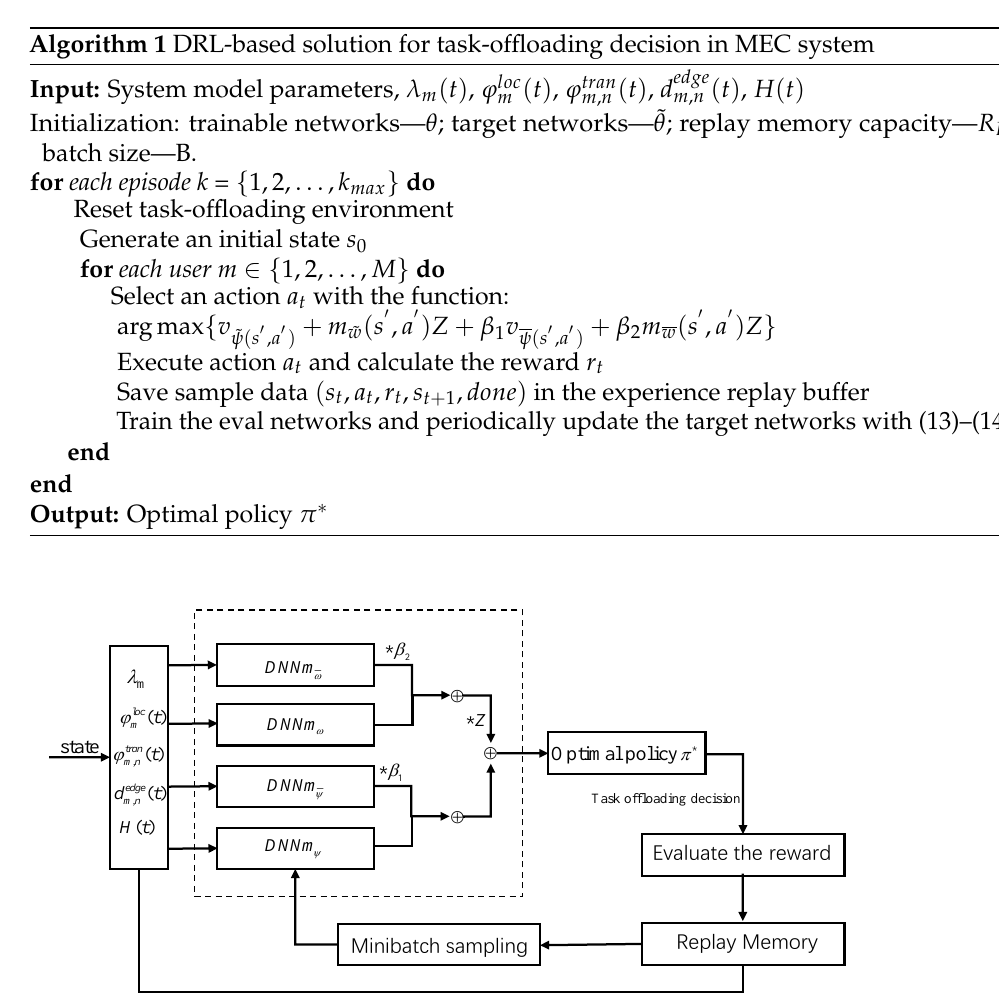
Figure 2. Network training and parameters updating process. * represnts the element